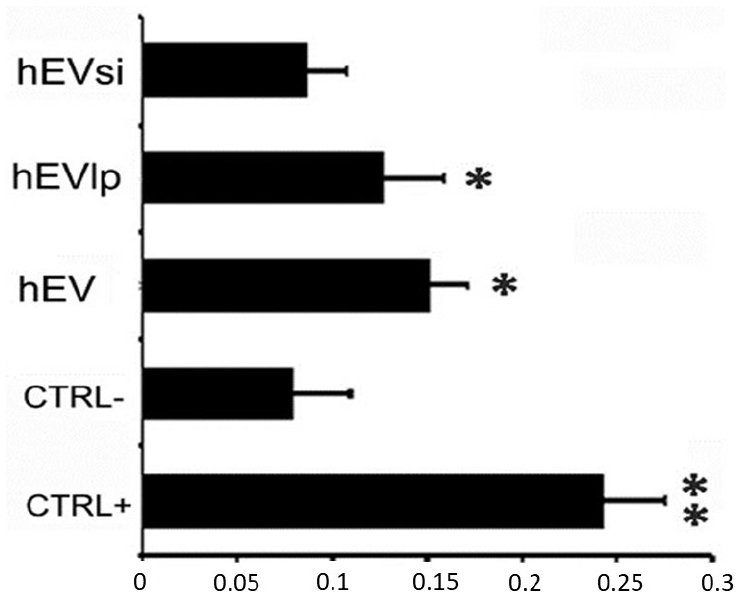
Figure 3. Effects of different types of extracellular vesicles (EVs) on the proliferation of human renal proximal tubular epithelial cells (RPTECs). The effects of the following types of EVs on the proliferation of human RPTECs was assessed using bromodeoxyuridine uptake with respect to the negative control cells (CTRL − , serum-free Dulbecco modified Eagle medium): hEVs, EVs obtained from naïve human mesenchymal stromal cells (hMSCs); hEVlp, EVs obtained from hMSCs transfected in the absence of a CD73-specific small interfering RNA (siRNA); and hEVsi, EVs obtained from hMSCs transfected in the presence of CD73-specific siRNA. Cells cultured in complete medium (renal epithelial basal medium) were used as positive controls (CTRL+). Data are expressed as mean ± SD of the absorbance in 3 different experiments performed in quadruplicate. Analysis of variance with the Newman-Keuls multiple comparison test was performed: ** p < 0.001 CTRL+ vs. CTRL − and * p < 0.05 hEVs and hEVlp vs. CTRL − .